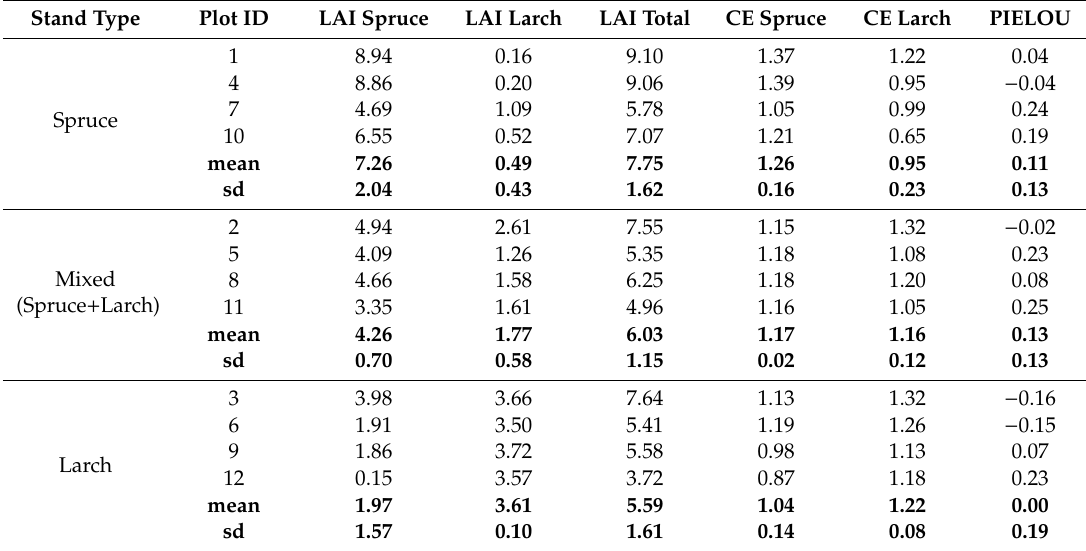
Table 3. Leaf area indices and indices characterizing the horizontal spatial distribution of the species. LAI is the leaf area index [m 2 / m 2 ]; CE is the Clark–Evans index; PIELOU is Pielou’s Segregation index; sd is the standard